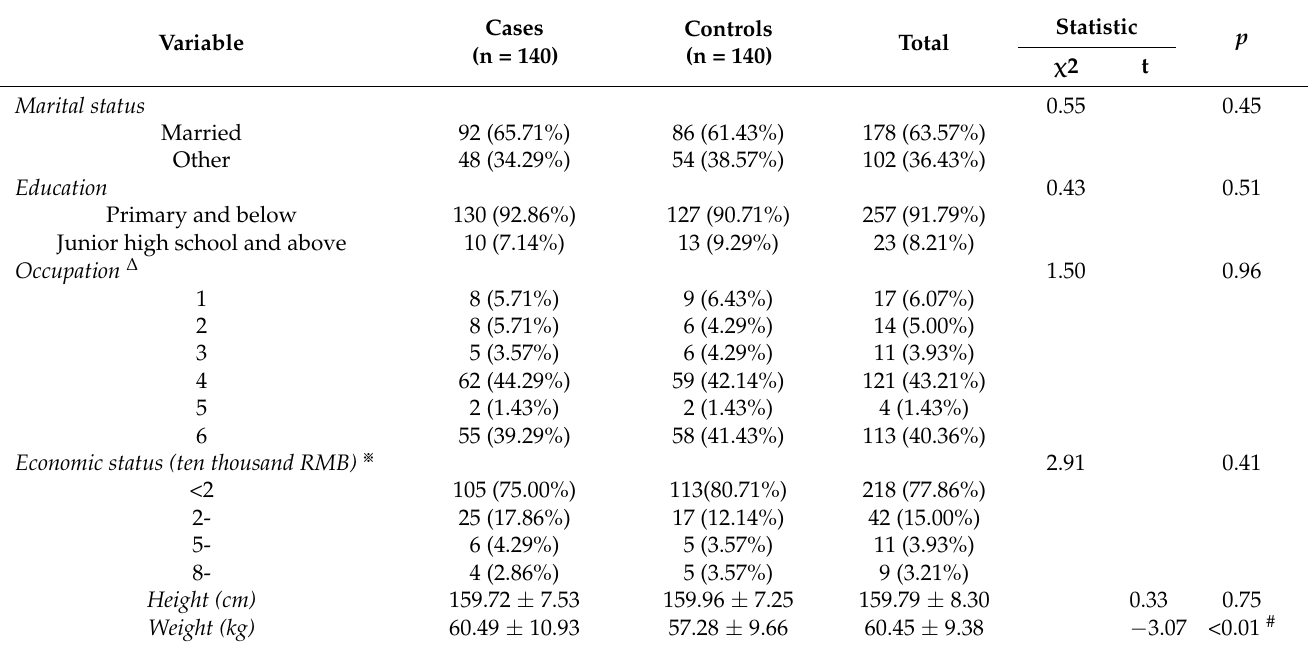
Table 1. Baseline characteristics in the case group and control group